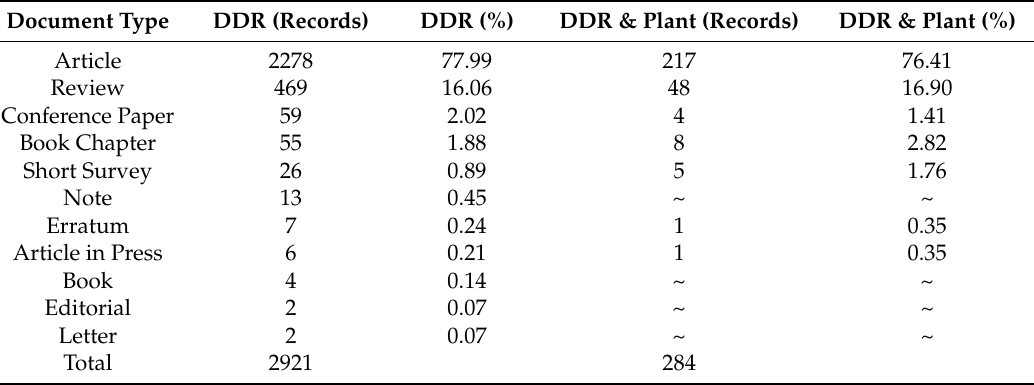
Table 1. Distribution of document types for research on DDR and DDR &